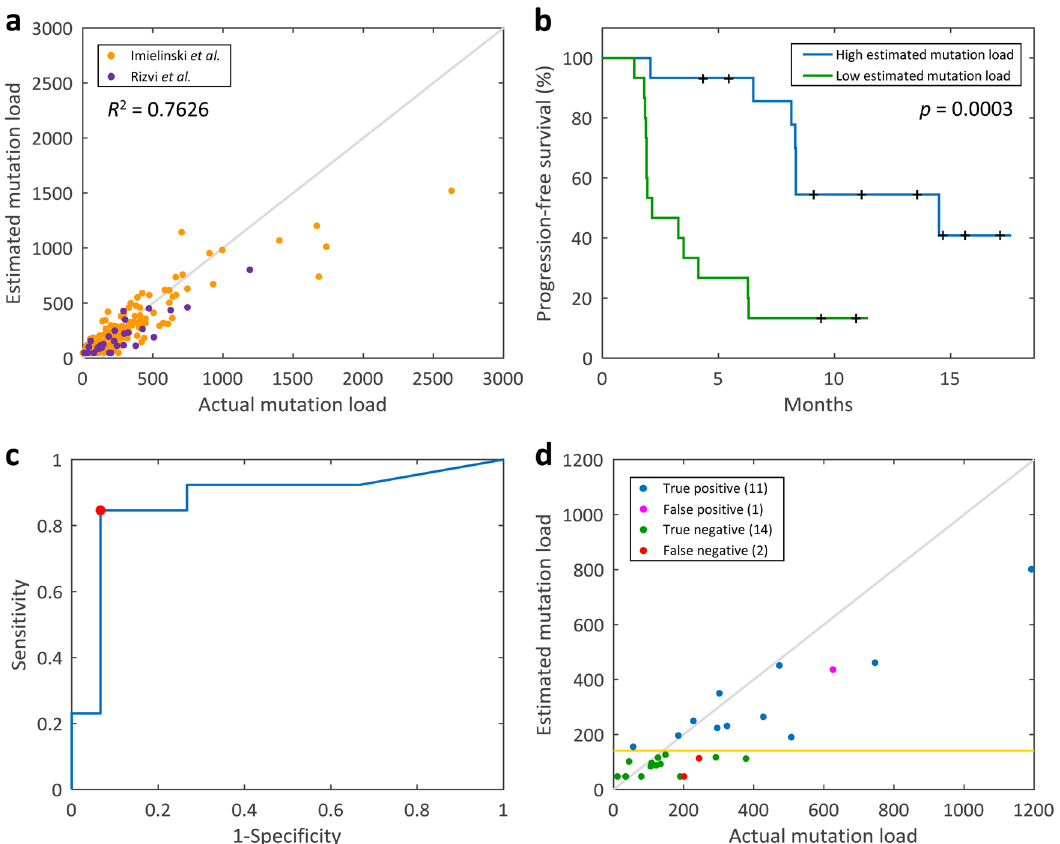
Fig. 2 Performance evaluation of the mutation load estimation model. a Estimated mutation load vs. actual mutation load using the independent validation data ( n = 211). b Survival analysis comparing PFS in patients with the high estimated mutation loads ( n = 15) with those with the low estimated mutation loads ( n = 15). The log-rank test results indicate that the higher estimated mutation load correlates with improved PFS ( p = 0.0003). c ROC curve for the classi fi cation of DCB/NDB patients using the estimated mutation load. The red point indicates the optimal discrimination threshold 141. AUC = 0.8744. d Immunotherapy response prediction using the estimated mutation load. Gold horizontal line represents the optimal discrimination threshold,